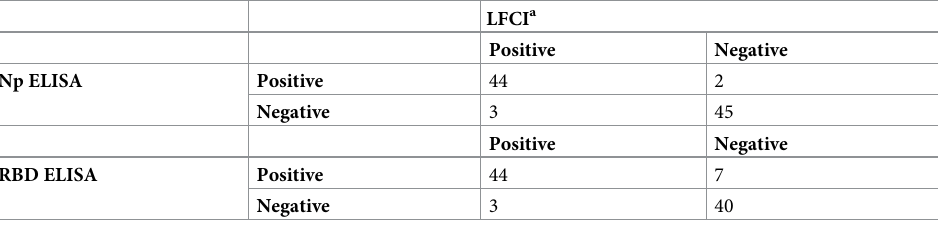
Table 1. Cross-tabulation of in-house ELISAs (Np & RBD ELISA) results and a commercial lateral flow chro- matographic immunoassay (LFCI)